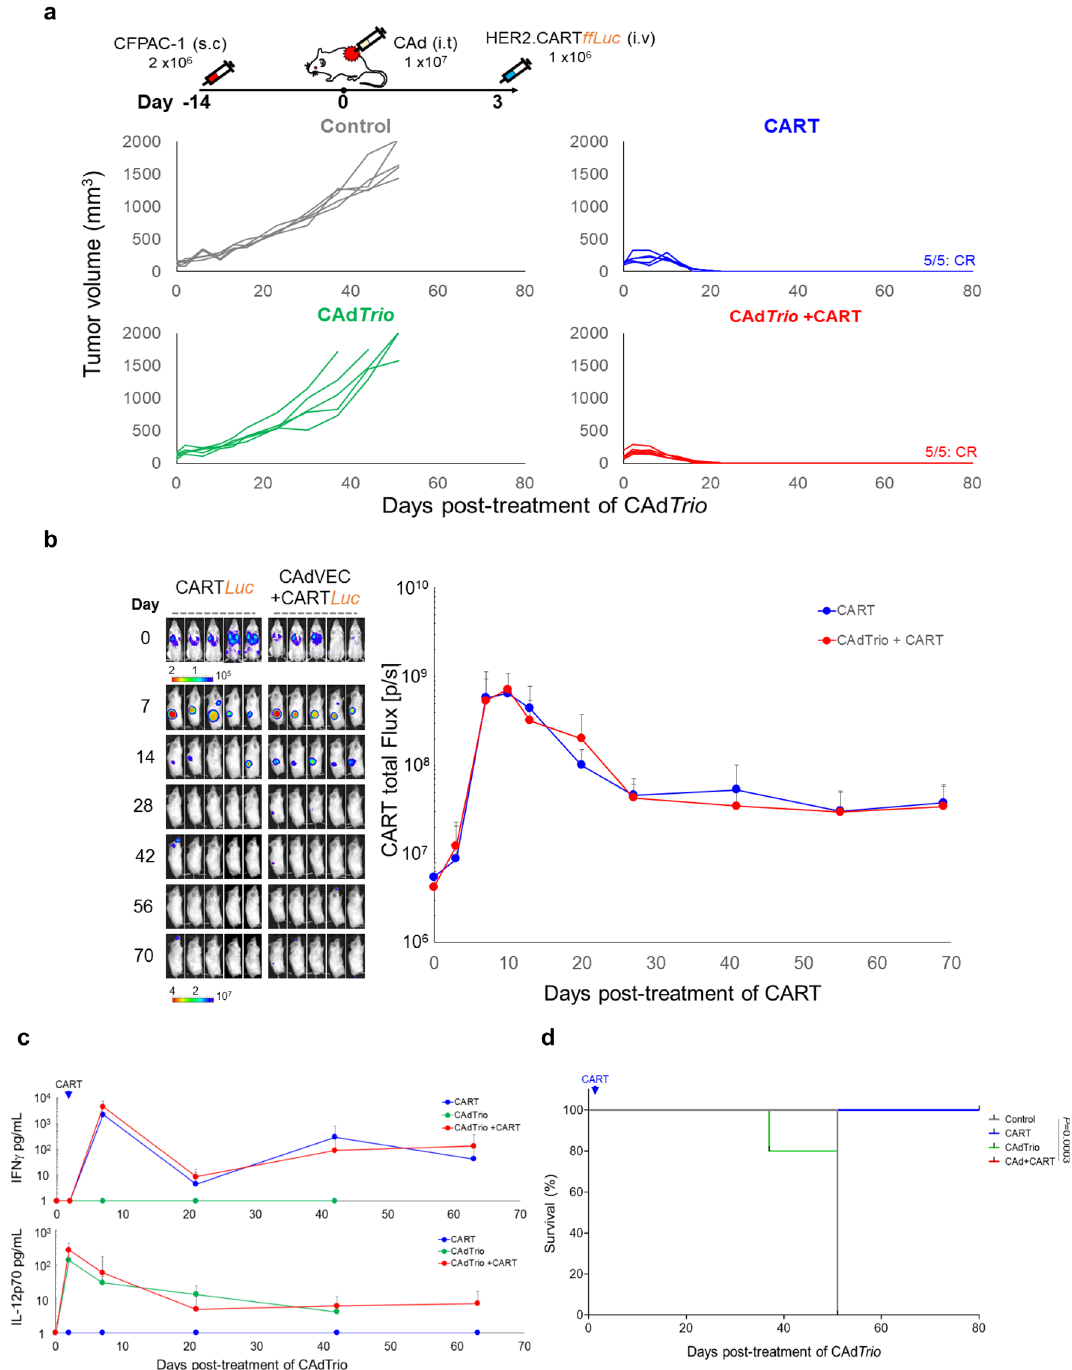
Fig. 2 HER2.CARTs primarily control CFPAC-1 tumor growth in xenograft mouse model. a CFPAC-1 cells were transplanted into the right fl ank of NSG mice ( n = 5 animals). A total of 1 × 10 7 vp of CAdTrio (OAd:HD = 1:1) were injected i.t.. A total of 1 × 10 6 HER2.CARTs expressing ffLuc were administered i.v. 3 days post injection of CAd Trio . Tumor volumes were monitored at different time points. b Bioluminescence of HER2.CARTs was monitored at the indicated time points. Data are presented as means ± SD. c We collected serum samples from mice at 0, 3, 7, 21, 42, and 63 days post injection of CAd Trio , and measured IFN γ and IL-12p70 levels by ELISA. Data are presented as means ± SD. d Kaplan – Meier survival curve after CAd Trio administration in mice ( n = 5 animals) p = 0.0003. P -values were determined using the log-rank Mantel – Cox test (dF = 3). Statistical signi fi cance set at p < 0.05, ns >